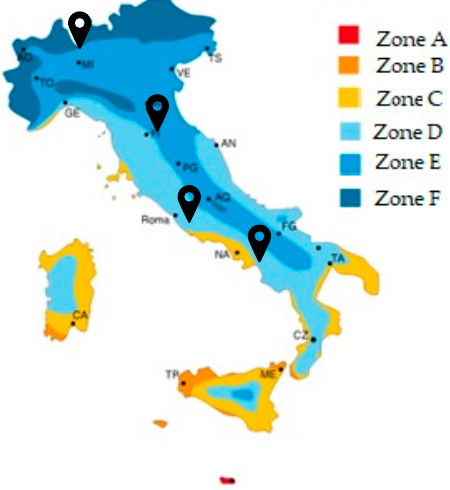
Figure 1. Italian territory climatic areas and the reference cities.